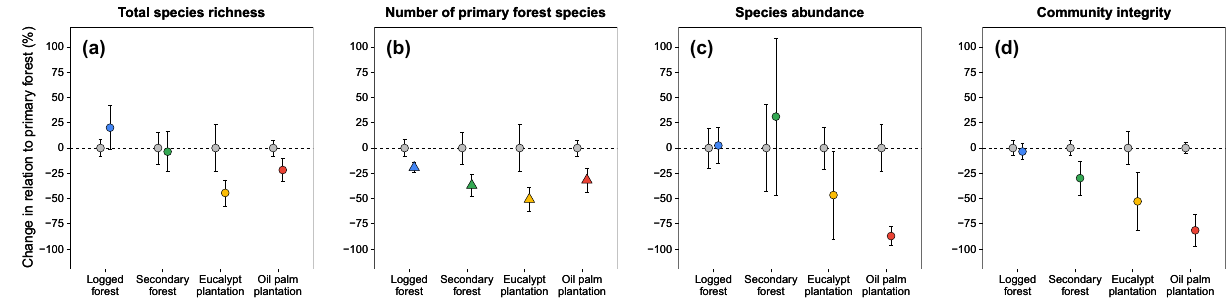
Figure 3. Percentage changes (mean ± 95% CIs) in assemblage-wide metrics within anthropogenic habitats compared to their adjacent primary forest baselines: ( a ) rarefied species richness , ( b ) rarefied number of primary forest species , ( c ) overall abundance, and ( d ) community integrity . Triangles indicate metrics when only primary forest species were included and are colour-coded according to habitat type: primary forest (grey), logged forest (blue), secondary forest (green), eucalyptus plantation (yellow) and oil palm plantation